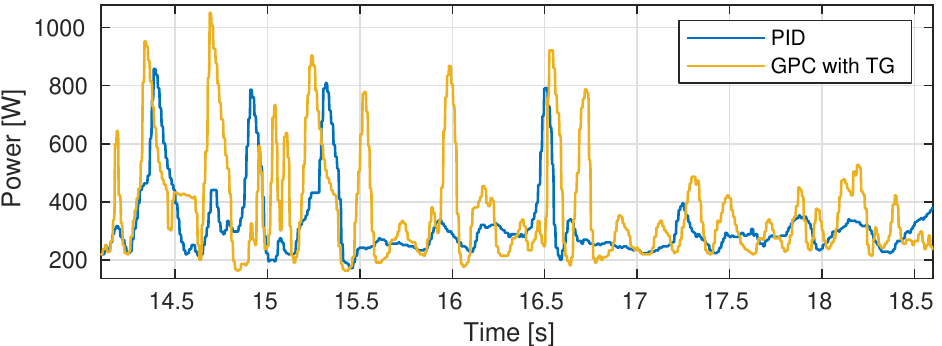
Figure 8. Power usage during the selected part of the Fixed Trajectory Experiment: MPC (with Trajectory Guessing) compared to PID.